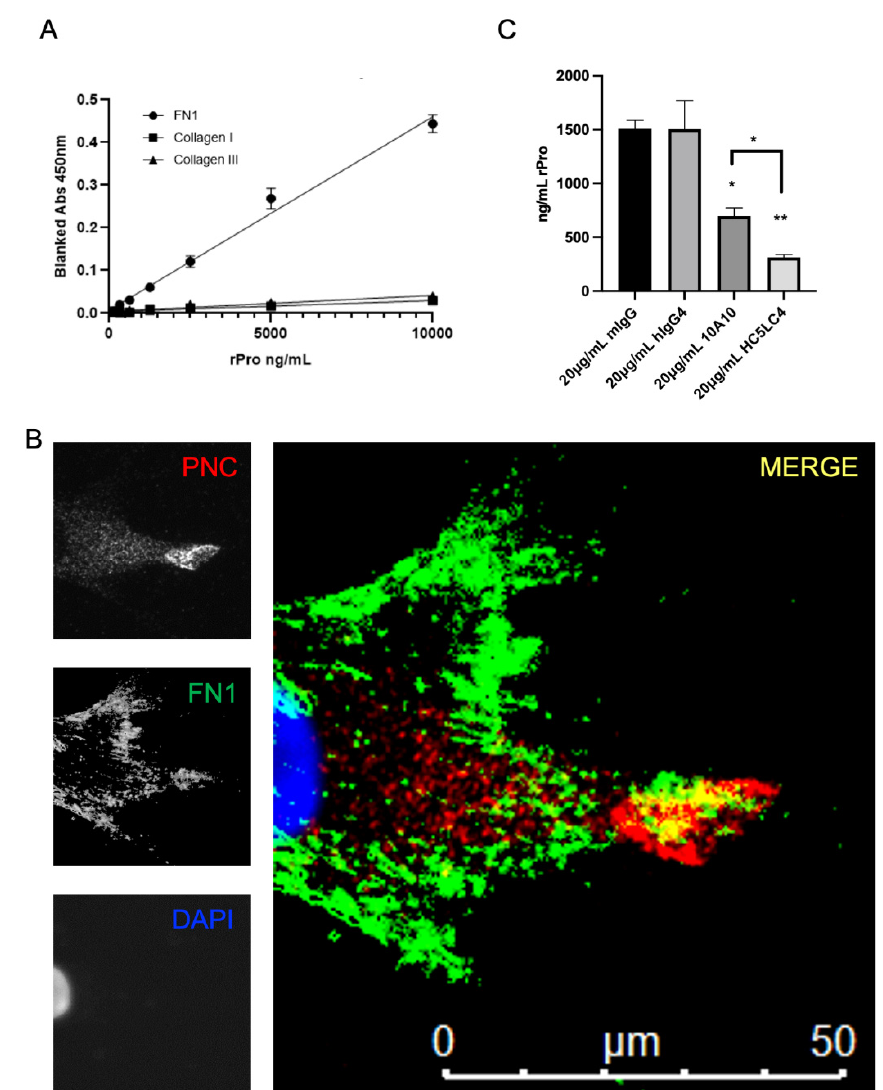
Figure 5. FN1 is a potential PNC binding partner. ( A ) Medium binding ELISA plates were coated with human fibronectin, collagen type I, or collagen type III, then blocked and incubated with his- tagged recombinant N-cadherin prodomain. After washing unbound prodomain, prodomain binding to the immobilized substrate was measured using a biotinylated his-tag specific monoclonal antibody and streptavidin-HRP for detection. Assay was performed in quadruplicate and is representative of at least 3 independent experiments. ( B ) Representative image of a cardiac myofibroblast isolated from failed cardiac explant tissue showing colocalization of PNC and FN1 immunostained for PNC (red), FN1 (green) and DAPI (blue). Yellow indicates PNC/FN1 colocalization (Merge). ( C ) Medium binding ELISA plates were coated with fibronectin, blocked, then incubated with either recombinant prodomain of N-cadherin or prodomain in combination with mouse IgG1 isotype control, human IgG4 isotype control, m- α -PNC mAb 10A10 or h- α -PNC mAb HC5LC4. Bound recombinant prodomain was detected using anti-his-tag monoclonal antibody in technical duplicates and representative of at least 3 independent experiments ( n = 3). Ordinary one-way ANOVA analysis with Tukey’s multiple comparisons test was performed to determine significance (* p ≤ 0.05, ** p ≤ 0.01).